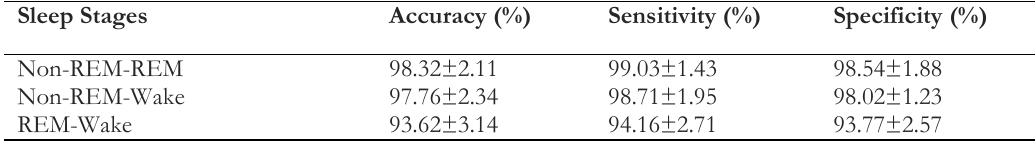
Table 5. Neural network performance using optimal